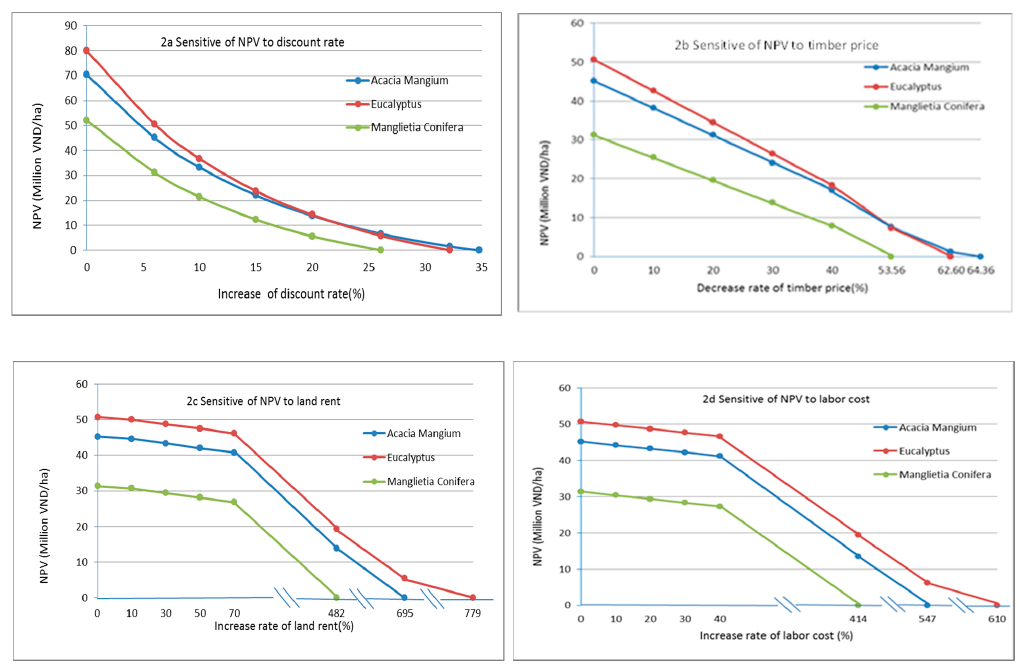
Figure 2. Sensitivity of NPV to the discount rate (2 a ); the timber price (2 b ); the land rent (2 c ); and the labor cost (2 d ).